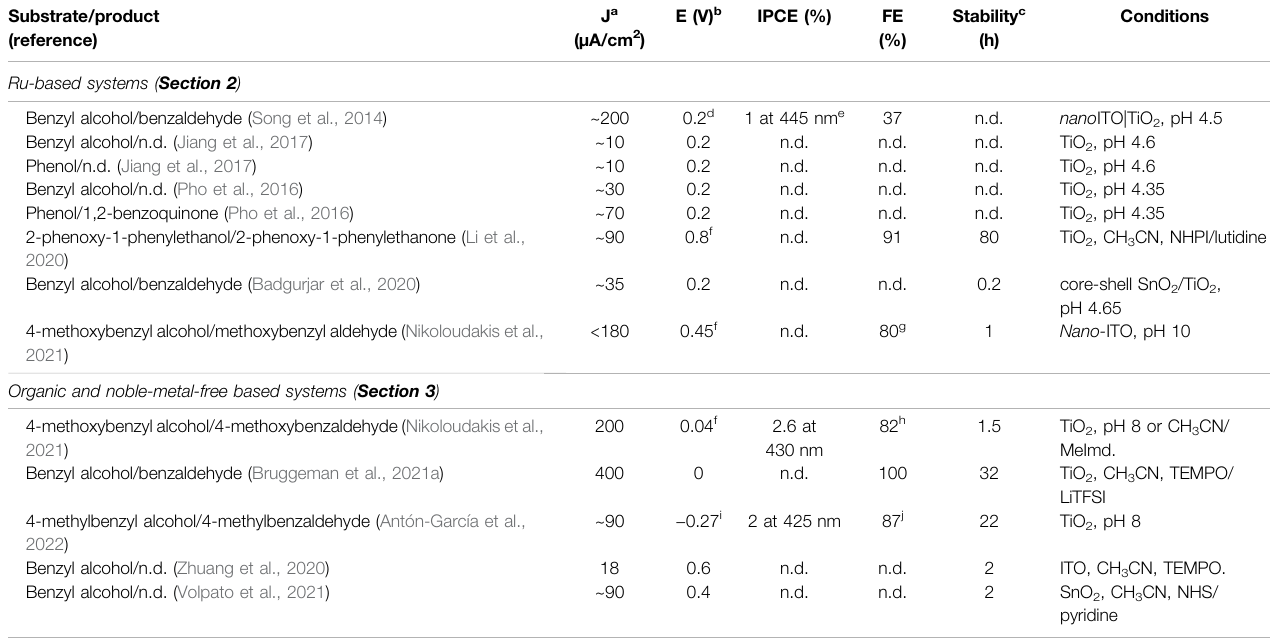
TABLE 1 | Relevant photoelectrochemical data of the systems discussed in Systems Based on Ruthenium Complexes section and Systems Based on Noble-Metal-Free and Organic Sensitizers section used in the oxidation of organic substrates. Substrate/product (reference) Ru-based systems ( Section 2